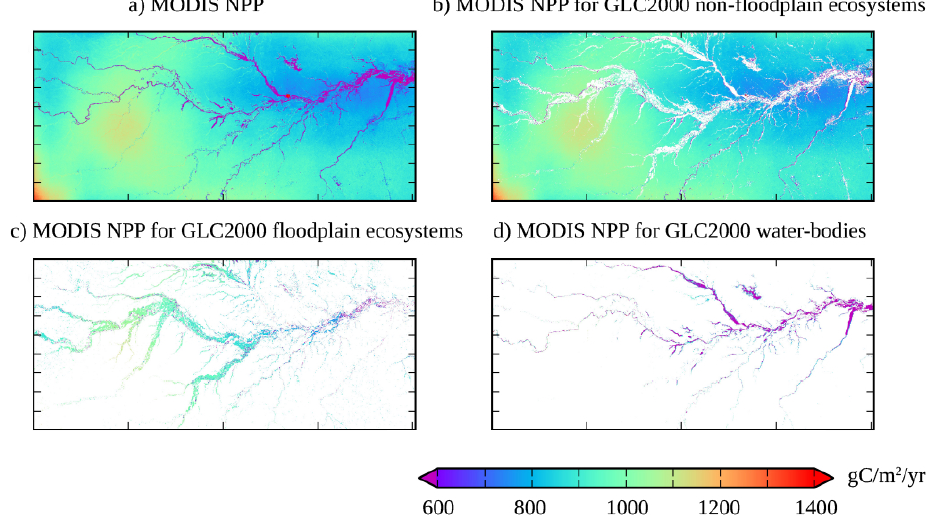
Fig. A3. MODIS-derived NPP for different ecosystems at GLC2000 resolution over the quadrate defined by Hess et al. (2004). Total MODIS NPP is displayed (a) , as well as MODIS NPP for non-floodplain (b) , floodplain (c) and water bodies (d) as defined in GLC2000.